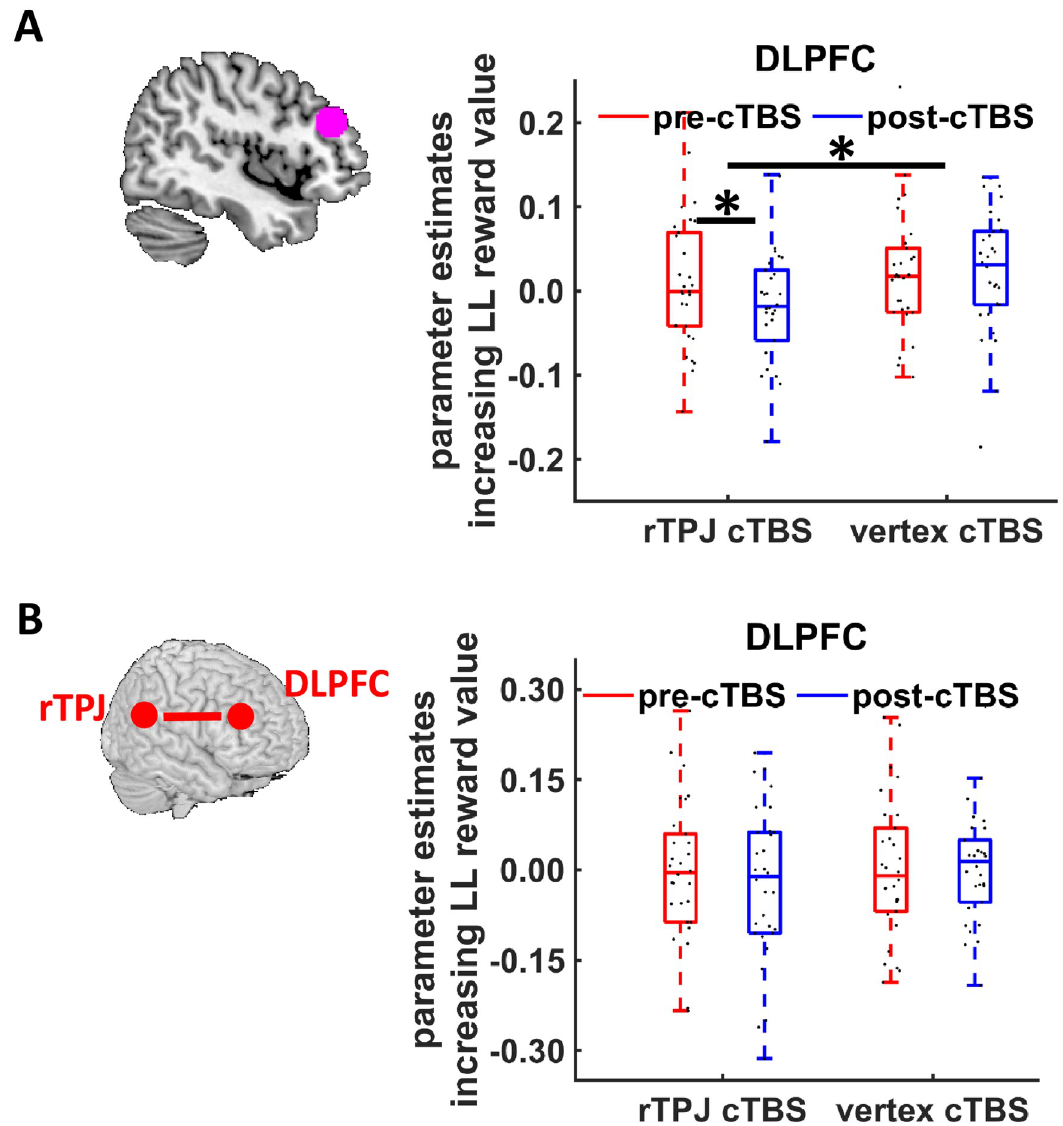
Fig 6. Effects of rTPJ cTBS on (A) value-related DLPFC activation and (B) connectivity between rTPJ and DLPFC. (A) Neural encoding of delayed (future) reward value in the DLPFC. Parameter estimates for value-related DLPFC activation were significantly reduced following rTPJ, not vertex, cTBS. (B) There was no evidence for cTBS effects on functional connectivity between rTPJ and DLPFC activation. Boxes indicate median (in red) and interquartile range. Black dots show individual parameter estimates. Asterisks indicate significant effects ( p < 0.05). The underlying data for this Figure can be found in S1 Data. cTBS, continuous theta-burst stimulation; DLPFC, dorsolateral prefrontal cortex; LL, larger-later; rTPJ, right temporoparietal